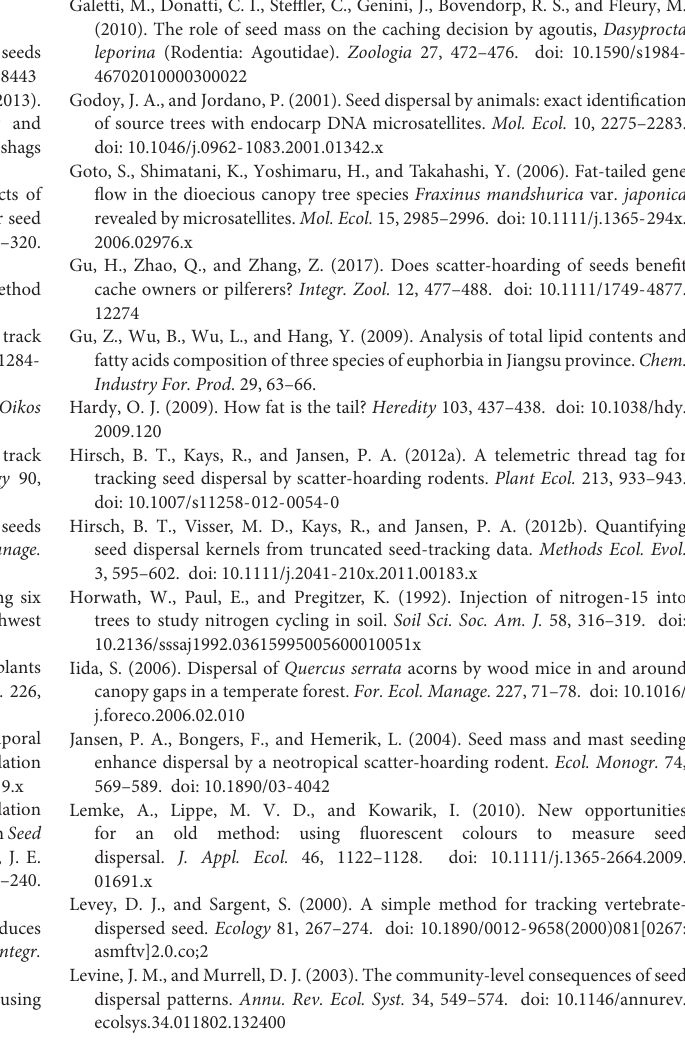
Supplementary Figure 1 | A map with the study area. Supplementary Figure 2 | An illustration of xylem injection of 15 NH 4 Cl and K 15 NO 3 into Quercus variabilis in the field. Supplementary Figure 3 | Isotopic values of seeds of several tree species xylem injected with 40 mmol/L 15 NH 4 Cl and K 15 NO 3 compared to the control. Supplementary Figure 4 | Difference in δ 15 N of enriched and natural seedlings of Quercus variabilis collected in the